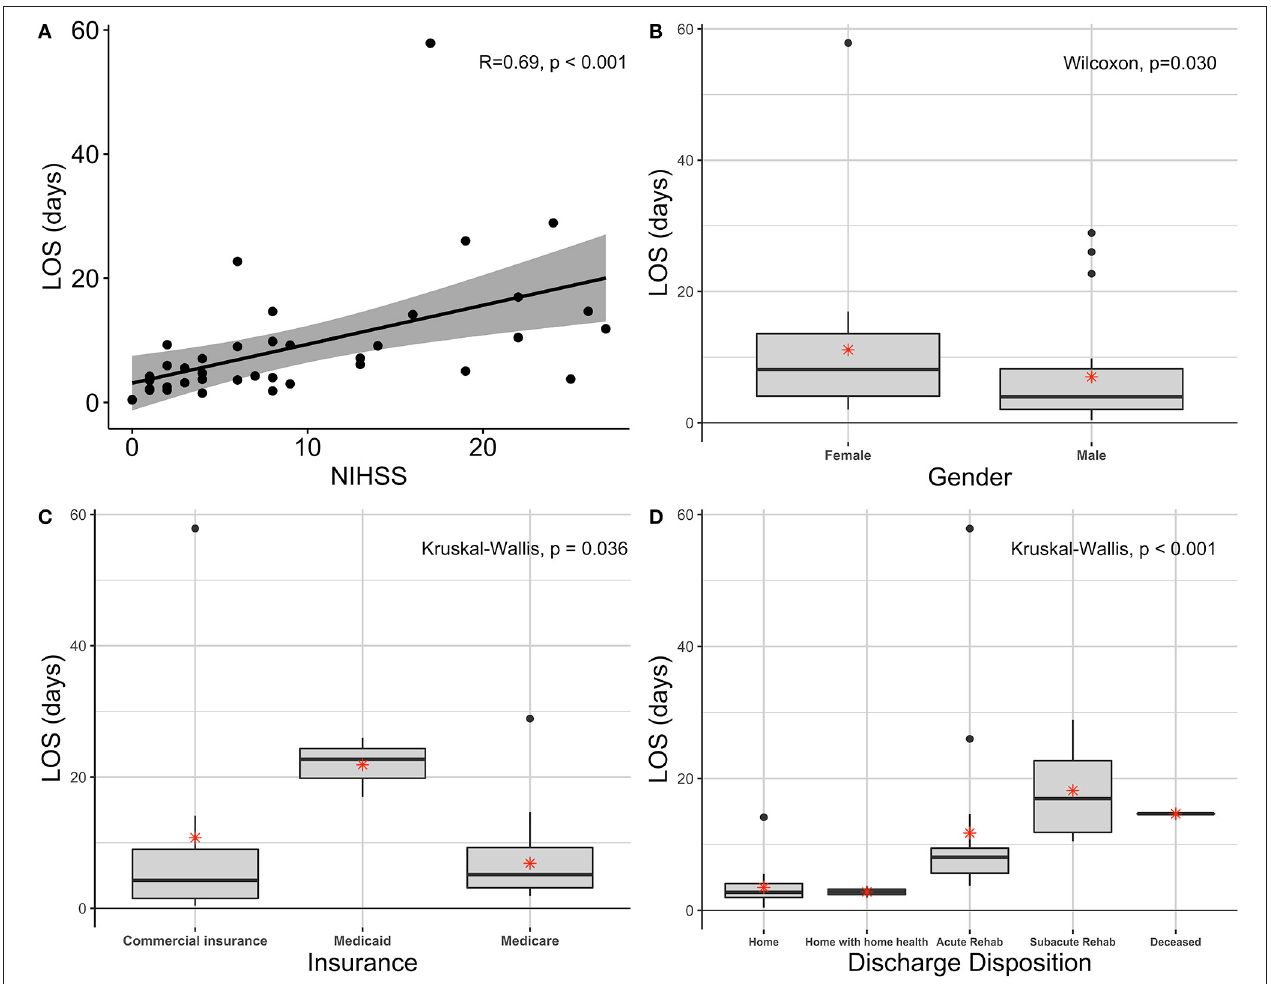
FIGURE 1 | Associations between clinical variables and LOS. (A) Scatterplot of LOS and admission NIHSS, r = 0.69, p < 0.001. (B) Boxplot of LOS based on male and female sex, p = 0.030. (C) Boxplot of LOS compared to type of patient insurance (commercial vs. Medicaid vs . Medicare), p = 0.036. (D) Boxplot of LOS compared to final discharge disposition, p < 0.001. Boxplots include the median and interquartile range. The asterisk denotes the mean. LOS, length of stay; NIHSS, National Institutes of Health Stroke